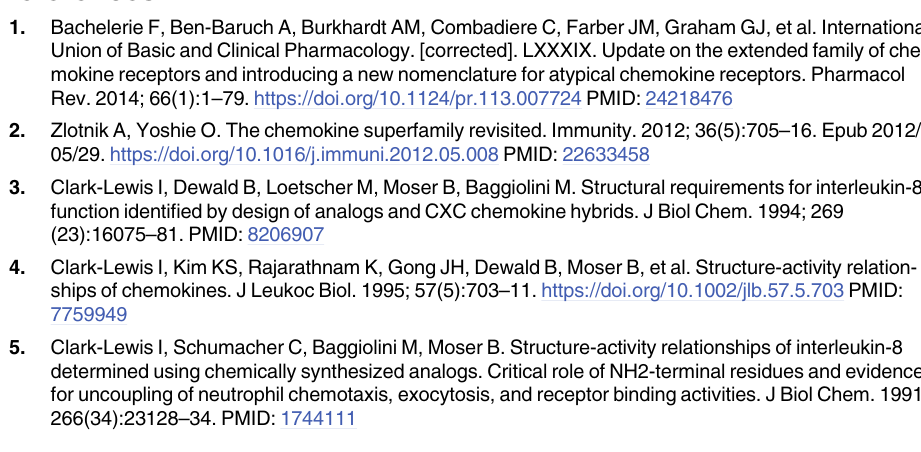
(TIF) S2 Fig. 1D 1H NMR spectrum of CXCL8. 1D 1 H NMR spectra of CXCL8 were recorded at 100 μ M. The spectrum exhibits well dispersed chemical shifts, indicative of a well-folded sam- ple. (TIF) S3 Fig. SEC-MALS of CXCL8 indicates dimerization. Differential refractive index and molar mass (g/mol) are plotted against elution volume. The differential refractive index is reported in blue. The molecular weight was calculated from the black line, which corresponds to the area of the peak used for this calculation. The reported molecular weight was 16.5 kDa ± 1.7%, in line with the expected molecular weight of the CXCL8 dimer which is 16.7 kDa. (TIF) S1 Table. A complete list of the 1H and 15N NMR chemical shifts assigned in this study.